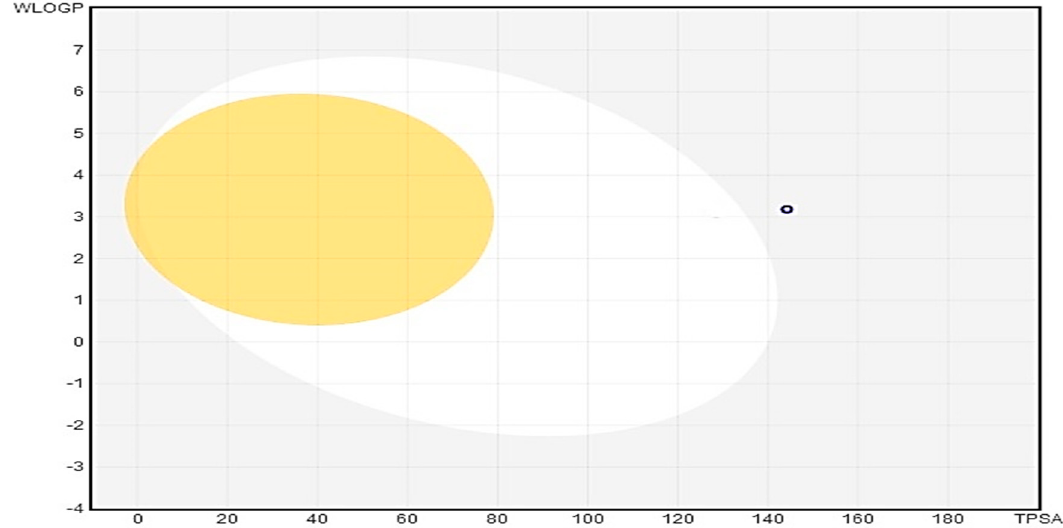
Figure 8. In silico ADME predictive plot: yellow portion indicates blood–brain barrier (BBB) permeability level, while the white portion indicated human intestinal absorption (HIA) level for 4e .